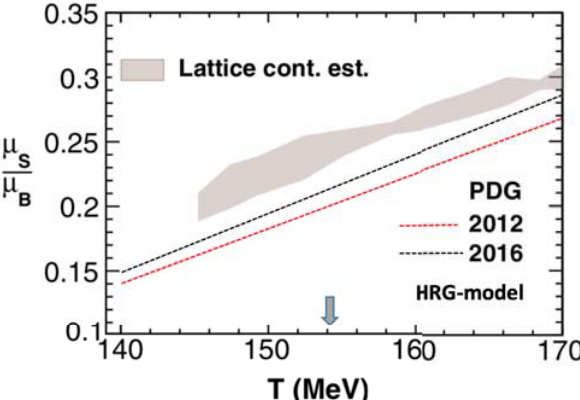
Fig. 6 Nucleon resonance spectrum below 2.2 GeV from LQCD [45]. The new discovered Nucleon states from RPP 2018 [12] are indicated by the red and blue ellipses with their spin-parity assignments. The observed masses deviate from the predicted ones as the lattice calculation used 396MeV pion mass, and no multi channel coupling is included. The green ellipses are well-known states that come out in the LQCD work with higher masses.